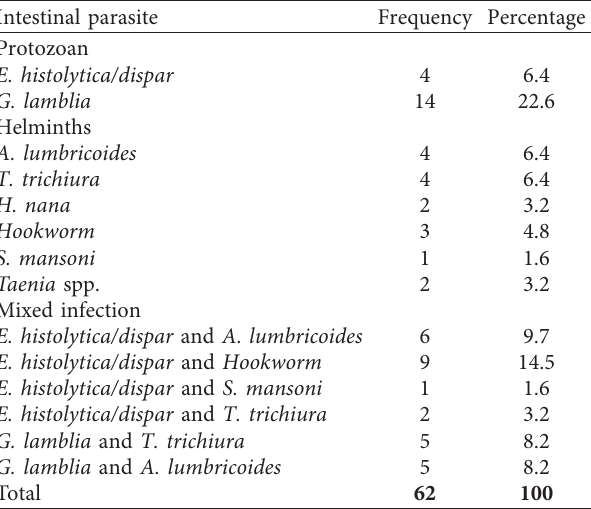
Table 3: Type and prevalence of intestinal parasites isolated from stool specimens of food handlers from food establishment areas of Mettu